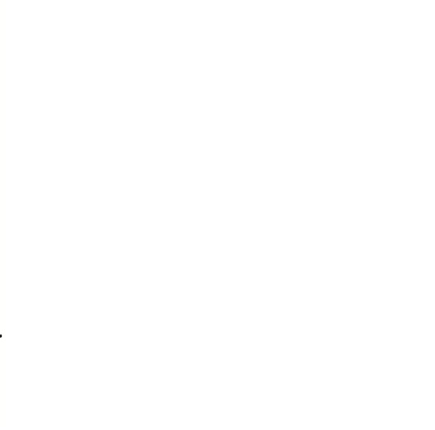
Figure 2. Real time qRT-PCR analysis of MyoD1 gene expression for the two selected cloned cell lines. ** p < 0.01.